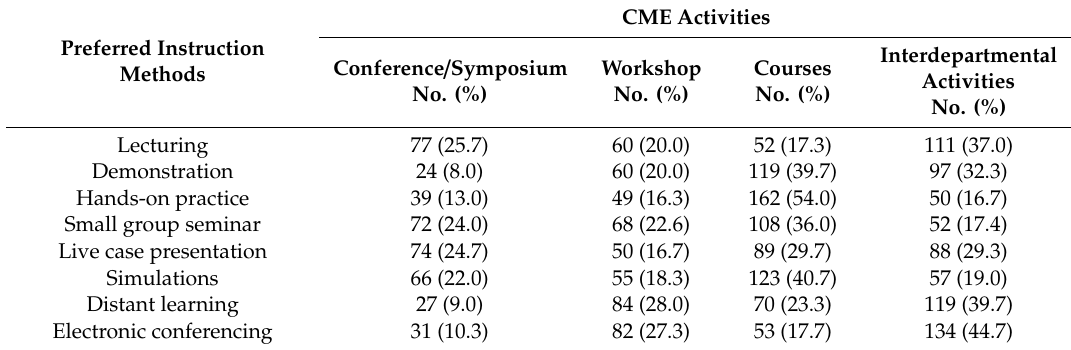
Table 2. Residents’ preferred methods ( n = 300) of instruction in the CME activities during the past one